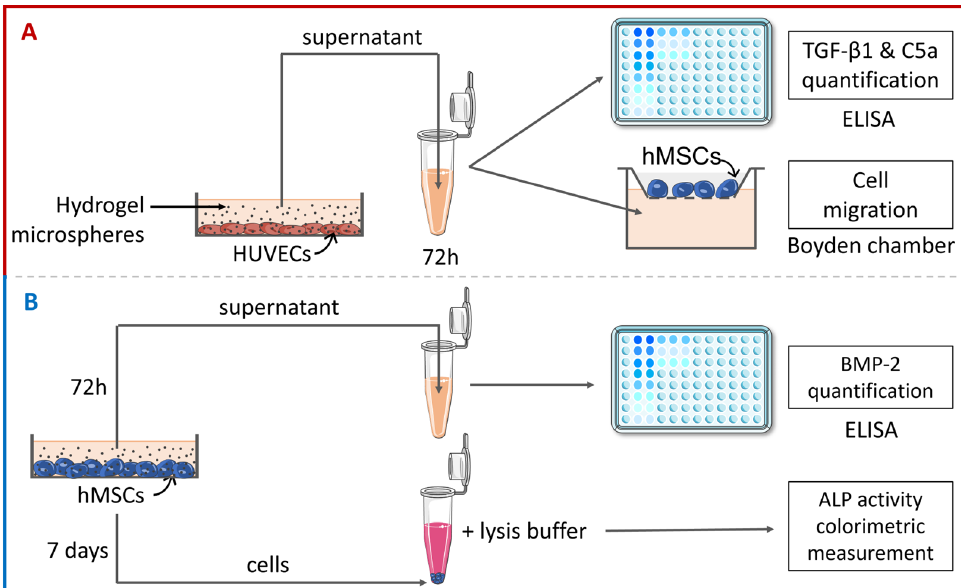
Figure 2. Representative sketch of the experimental protocol. ( A ) HUVECs and hMSCs were incubated with the hydrogel. After 72 h, the HUVEC supernatants were harvested and TGF ‐β 1 and C5a secretion was quantified by ELISA. Migration of hMSCs was studied using Boyden chambers with HUVEC supernatants. ( B ) Secretion of BMP ‐ 2 was quantified after 72 h in hMSC supernatants by Elisa while hMSC differentiation was investigated after 7 days by measuring Alkaline Phosphatase (ALP) activity on cell lysates using a colorimetric method.